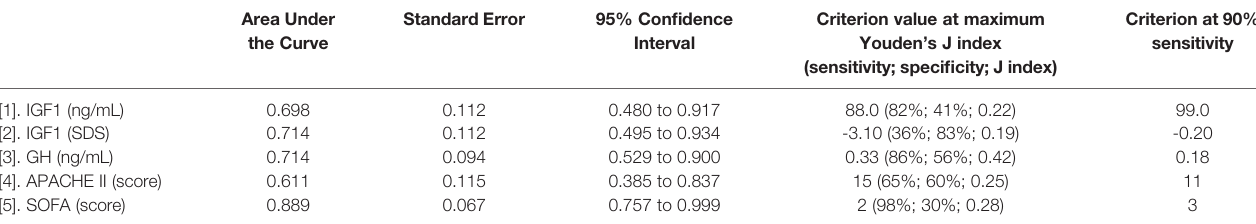
TABLE 3 | ROC plot analysis of prognostic tools ’ scores and IGF1/GH versus survival in ICU patients with Covid-19. Area Under the